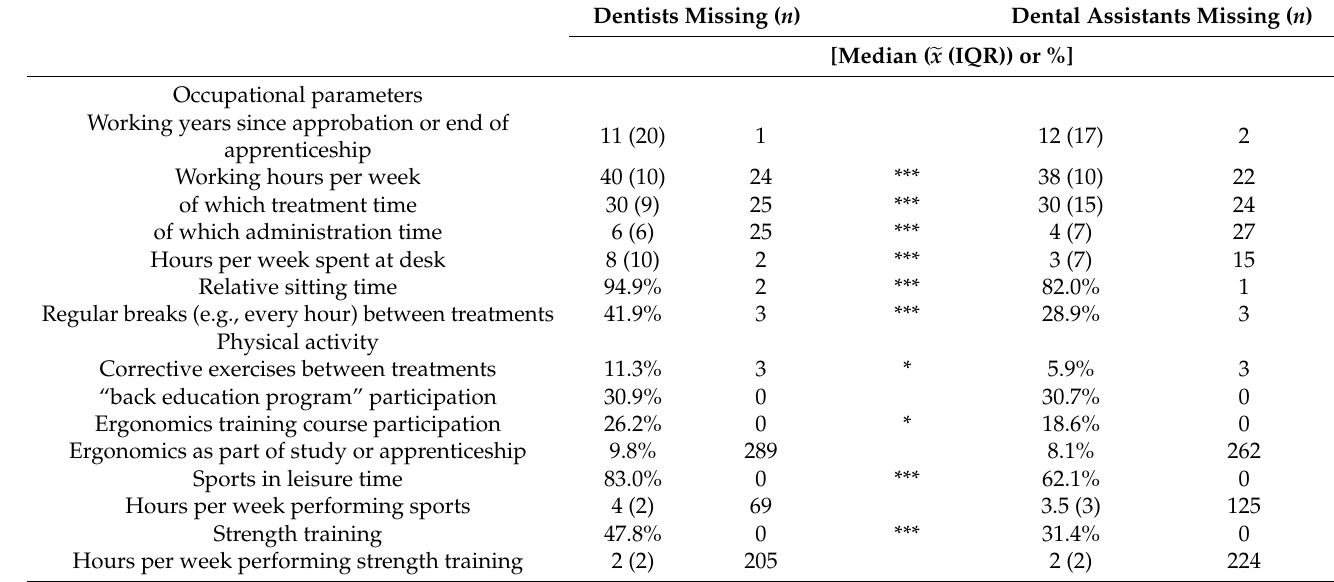
Table 2. Occupational parameters and physical